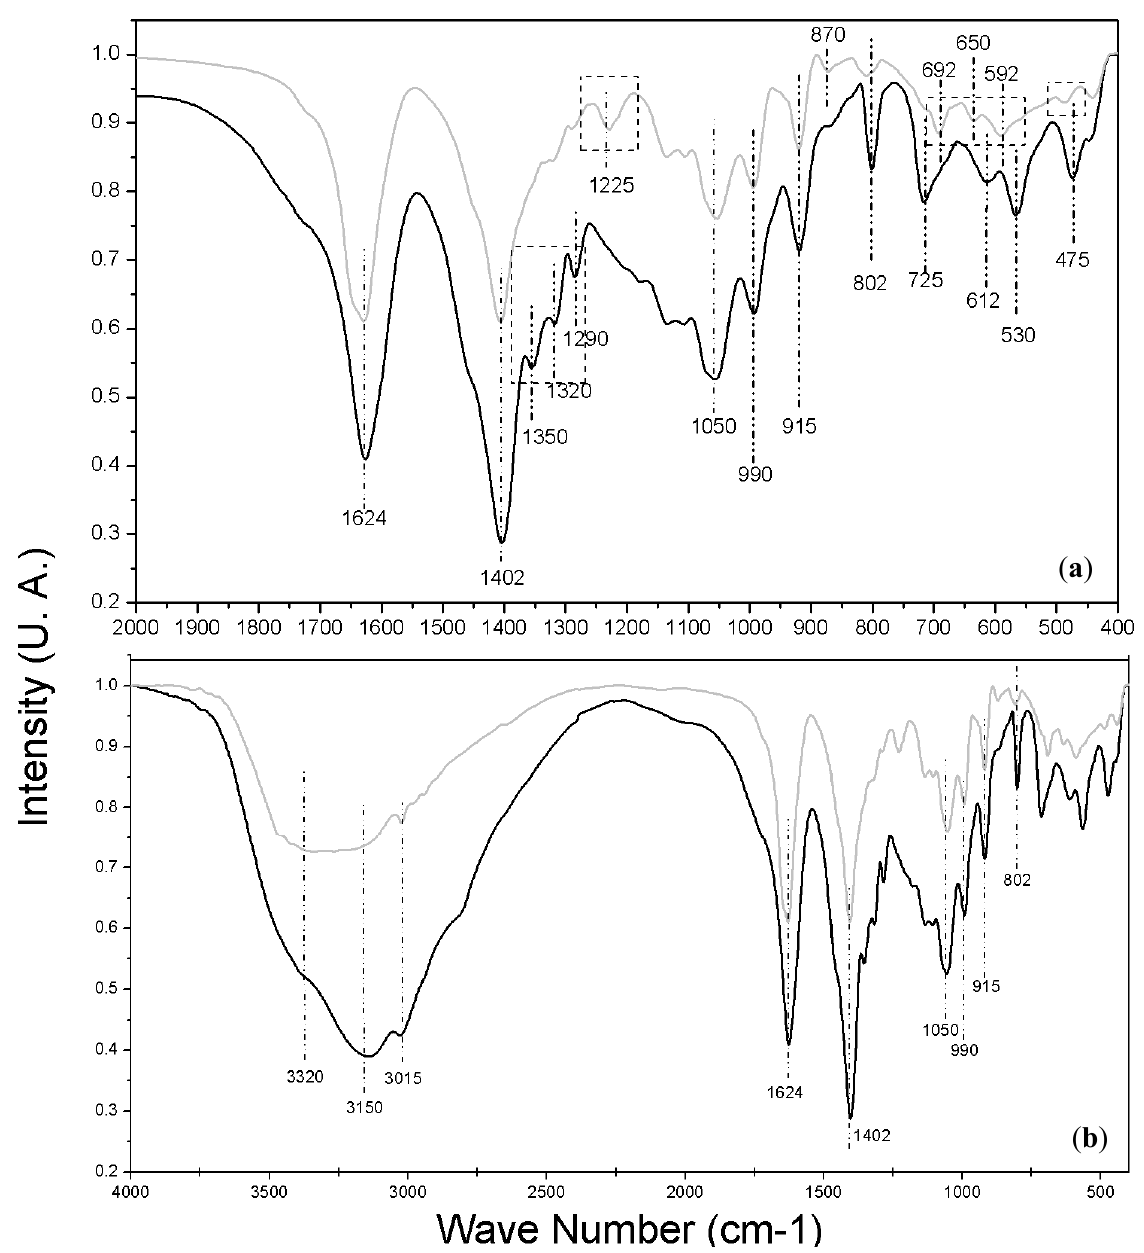
Figure 6. FT-IR Spectra Obtained; gray line for Beta vulgaris and black line for modified Beta vulgaris ; ( a ) Zoom IR spectrum from 400 to 2000 cm − 1 and ( b ) Full IR spectrum from 450 to 4000 cm − 1